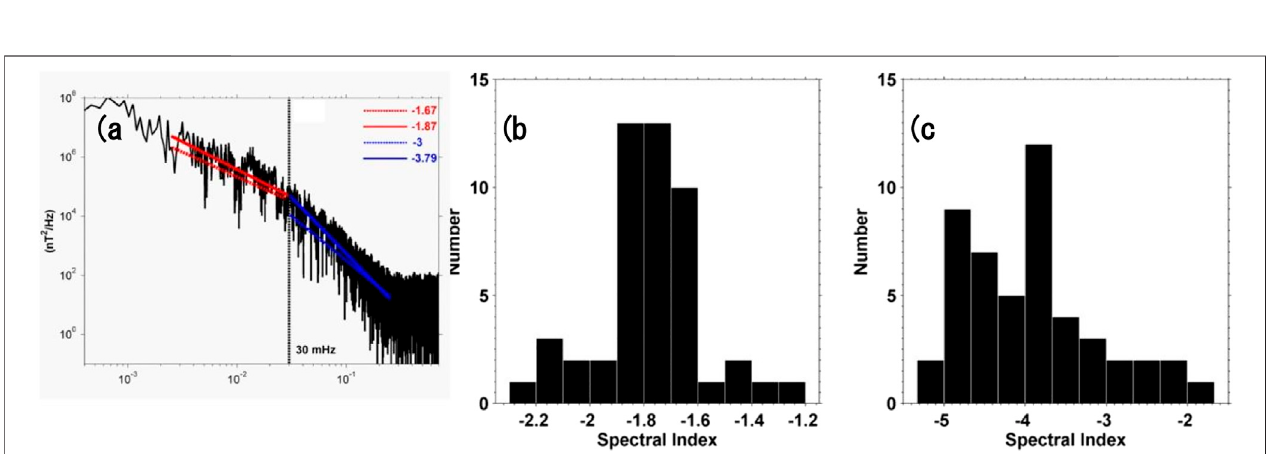
FIGURE3| B Z colorcontoursand fl owvectors(arrows)attime130 minintheequatorialplane.Panel (A) showstheglobalscalecon fi guration;panel (B) showsthe meso-scale vortices expanded; and panel (C) shows further expansion ofa selected region. Note that B z changes sign tailward of about 50 R E and is very patchy at this time. (After El-Alaoui et al. (2010)).